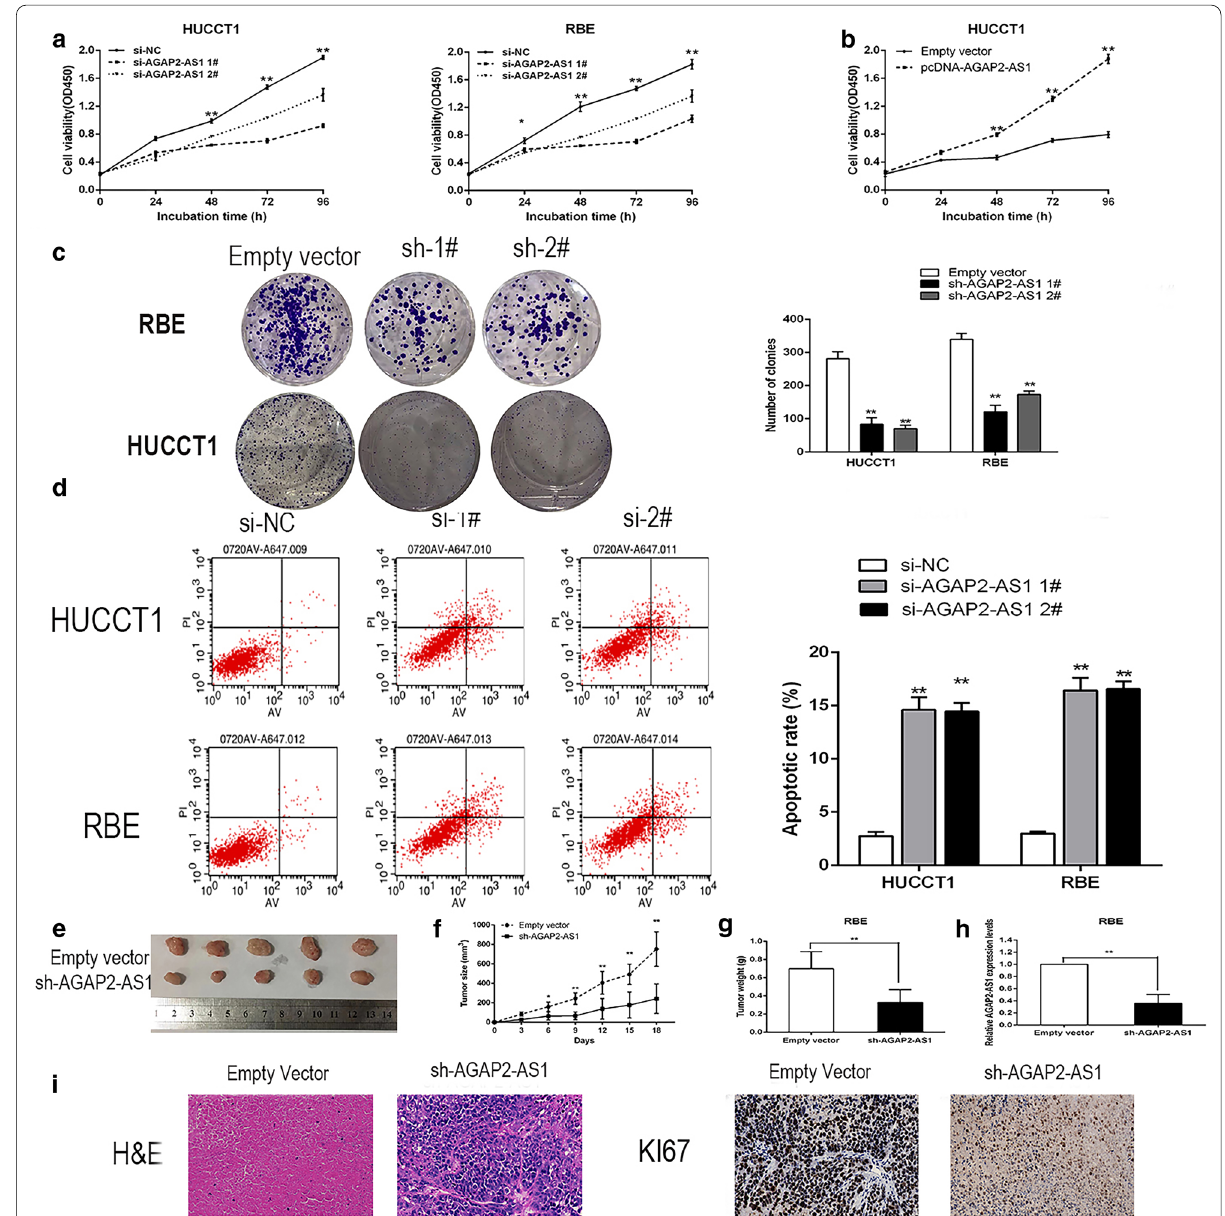
Fig. 2 AGAP2-AS1 promotes CCA cell proliferation in vitro and vivo. a , b CCK-8 assay was performed to determine the proliferation of HUCCT1 and RBE cells with si-AGAP2-AS1 1, 2, pcDNA-AGAP2-AS1, or the negative control. c Colony formation assays were performed to determine the proliferation of sh-AGAP2-AS1-transfected HUCCT1 and RBE cells. d The percentage of apoptotic cells was determined by flow cytometric analysis. e Stable AGAP2-AS1 knockdown were used for the in vivo study. Nude mice carrying tumors from respective groups were shown. f Tumor volumes were calculated every 3 days after injection. g Tumor weights from two groups are represented. h qPCR was performed to detect the average expression of AGAP2-AS1 in xenograft tumors. i Images of HE staining and immunohistochemistry in xenograft tumors. Representative Ki-67 protein levels in xenograft tumors as evaluated by IHC. Representative images and data based on three independent experiments. Bars: **P <